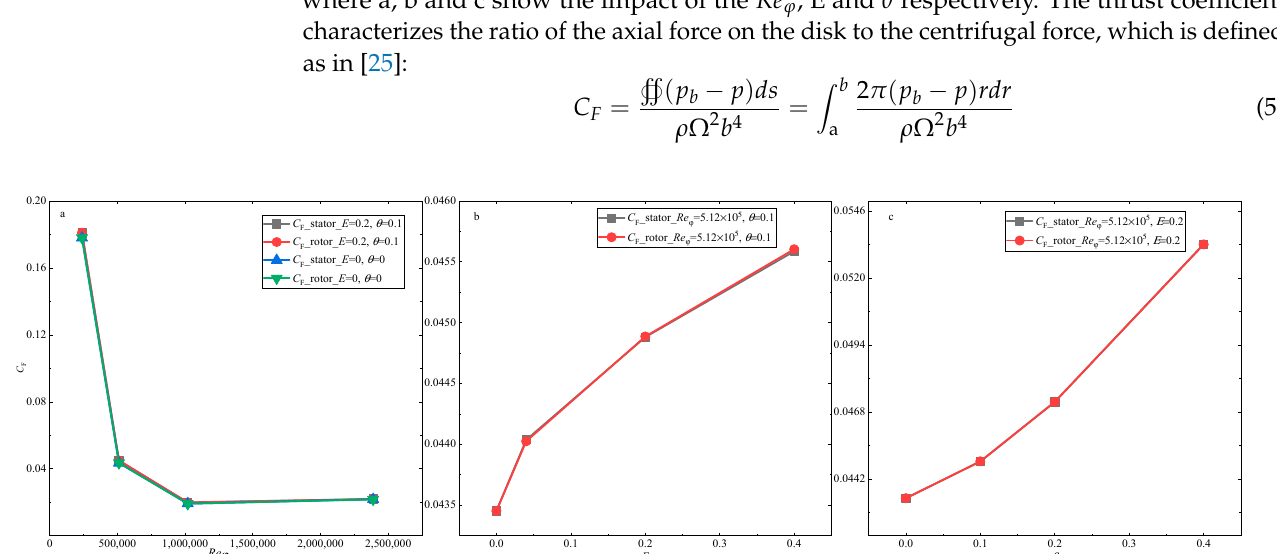
Figure 21. Pressure coefficient for (cid:1829) (cid:3050) = 10,137 , (cid:1844)(cid:1857) (cid:3101) = 5.12 × 10 (cid:2873) , (cid:1831) = 0.2 , at plane z / s = 0.5: ( a ) ϕ = 0, ( b ) ϕ = π , ( c ) ϕ = π + θ /2, ( d ) ϕ = π + θ .